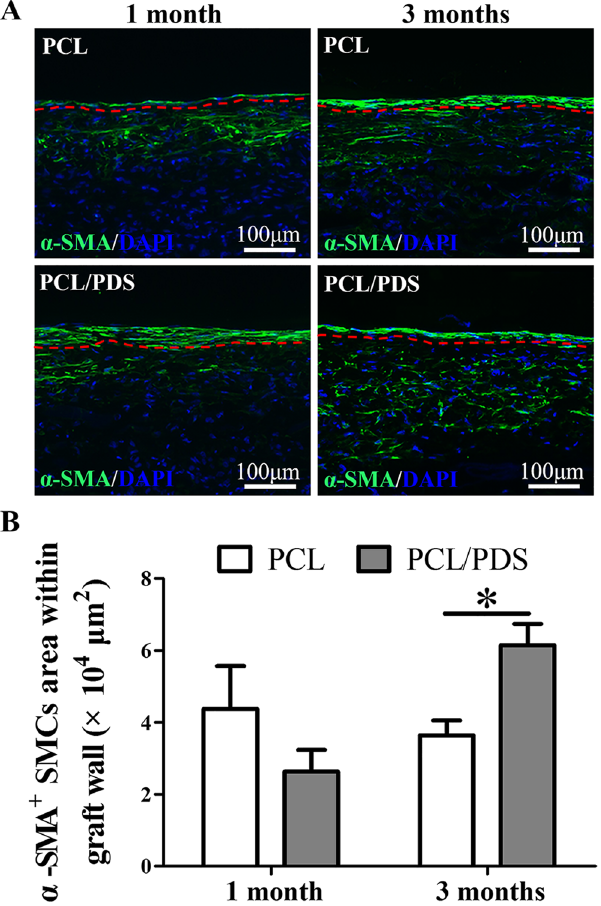
Figure 4. Synthetic smooth muscle regeneration of grafts at 1 and 3 months after implantation. ( A ) Longitudinal sections were stained with anti-smooth muscle actin ( α -SMA) antibody to identify the regeneration of synthetic phenotype SMCs. ( B ) The synthetic phenotype SMCs area within the graft walls were also calculated based on α -SMA staining. * p < 0.05. The region below the red line represented graft